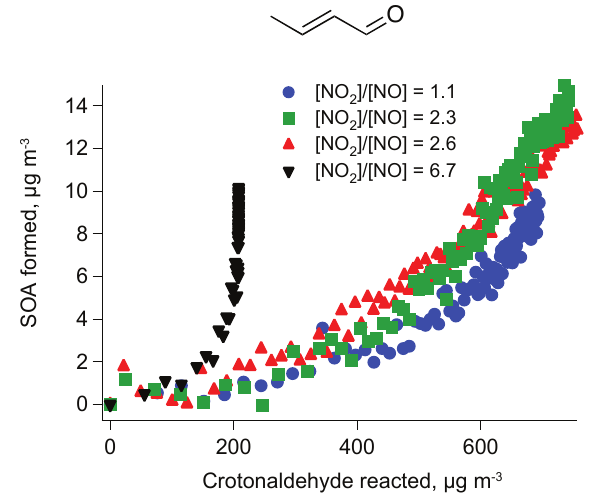
Fig. 5. Time-dependent SOA growth curves for crotonaldehyde photooxidation. Similar to methacrolein photooxidation, NO 2 /NO ratios are computed from photochemical modeling (see Appendix). In the high-NO experiments (NO 2 /NO < 3), HONO was used as the OH precursor, and the NO 2 /NO ratio was varied by adding differ- ent amounts of NO or NO 2 . In the high-NO 2 experiment (black triangles), CH 3 ONO was used as the OH